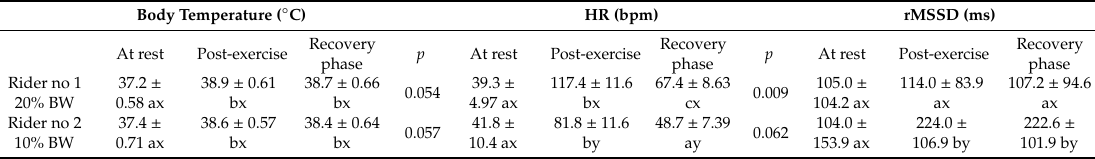
Table 7. Rectal temperature ( ◦ C) and heart rate parameters in the studied horses (Means ±